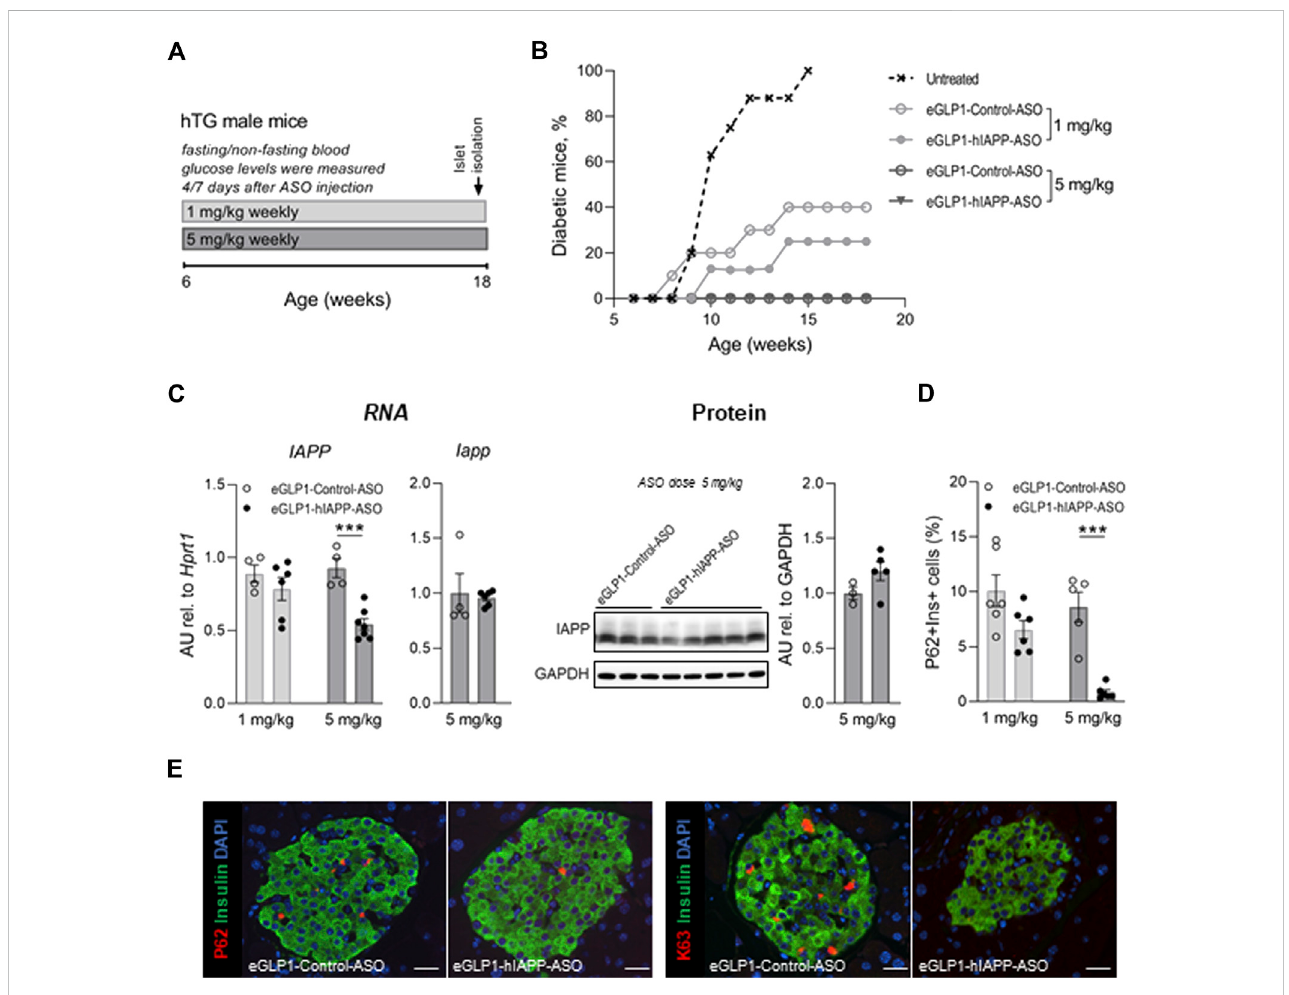
FIGURE 2 EffectoftreatmentwitheGLP1-hIAPP-ASO ondiabetesdevelopmentandautophagy/lysosome dependentpathwayofproteindegradationinbetacells. (A) Scheme of the experiment. Mice were treated weekly with eGLP1-hIAPP-ASO or with eGLP1-Control-ASO (eGLP1 peptide conjugated to an ASO with a scrambled nucleotide sequence). (B) Diabetes development (mouse was considered to be diabetic if blood glucose levels measured after overnight was > 125 mg/dl or non-fasting morning glucose aver 250 mg/dl). (C) Islet hIAPP RNA levels were decreased in dose dependent manner without noticeable effect on levels of the monomeric hIAPP protein relative to e-GLP1-Control-ASO treated mice. (D) The frequency of beta cells containing P62 positive inclusions decreased in eGLP1-hIAPP-ASO treated mice in a dose dependent manner. (E) Representative images of islets stained for P62 and K63 polyubiquitinated proteins destined for the autophagosome/lysosome mediated degradation (scale bar 25 mm). (C – E) Data are from non-diabetic mice only.Dataarepresentedasthemean±SEM;n=5 – 7in(b), n =4 – 6in(c); n =5 – 6in(f);***- p < 0.001,two-tailednon-pairedStudent ’ stest;hTG — humanIAPP